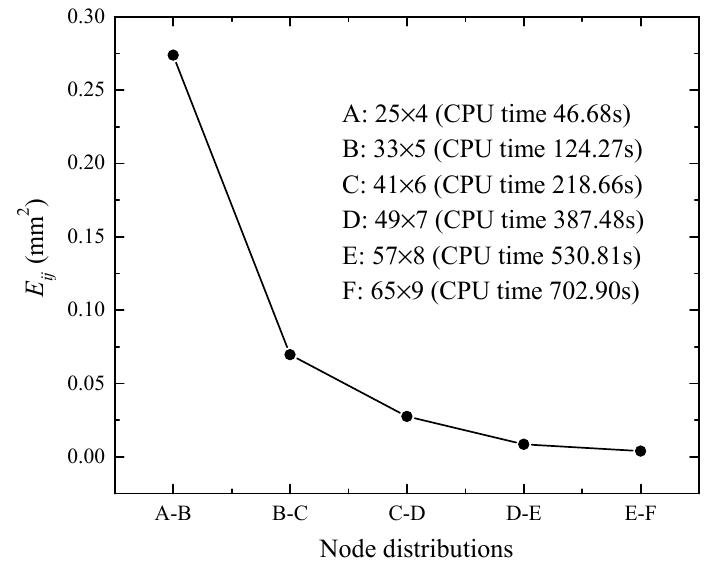
Figure 6. The convergence analysis and CPU time.